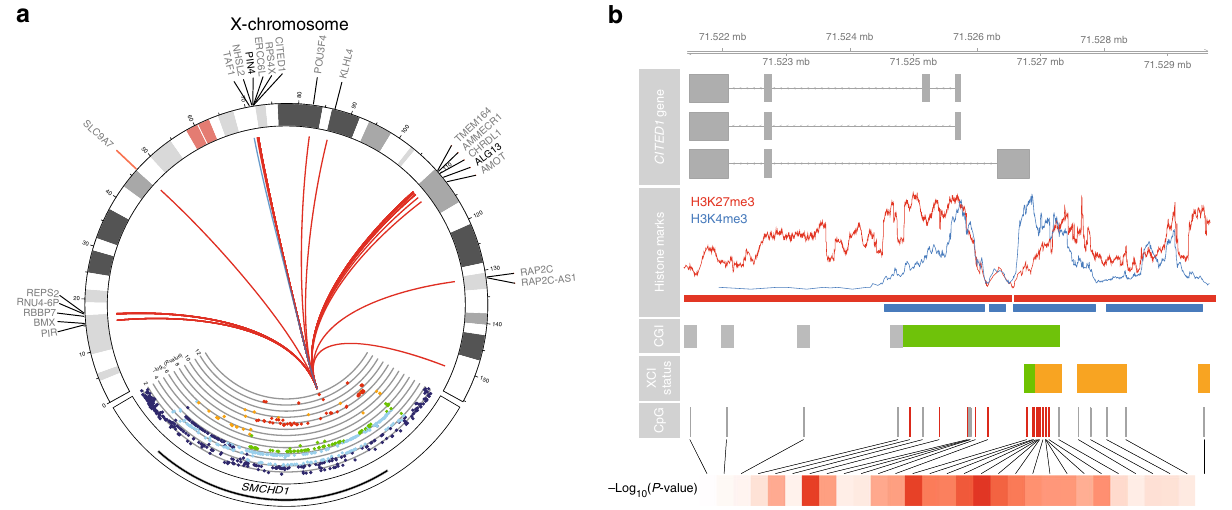
Fig. 2 The SMCHD1 / METTL4 locus associates with DNA methylation at X-chromosomal and autosomal regions. a Plot showing the SMCHD1 / METTL4 locus and the effects it has on the X-chromosome. The colors in the SMCHD1 / METTL4 locus indicate LD (red: R 2 ≥ 0.8; orange: 0.6 ≤ R 2 < 0.8; green: 0.4 ≤ R 2 < 0.6; light blue: 0.2 ≤ R 2 < 0.4; dark blue: R 2 0.6 ≤ 0.2). The y-axis shows the – log 10 ( P -value) of the association with overall X-chromosomal methylation. The line colors in the Circos plot indicate the direction of the effect (red: hypomethylation, blue: hypermethylation). The plot of the SMCHD1 / METTL4 locus mostly shows moderate to high LD and covers most of the SMCHD1 gene. The deletion of rs140837774 is associated with both downregulation of SMCHD1 and upregulation of METTL4 (see main text). Its effects on X-chromosomal methylation are abundant and consistent: the deletion of rs140837774 is associated with hypomethylation at 98.2% of all associated CpGs (56 CpGs, red lines, mean effect size 1% per allele). Hypomethylation of CpGs near two genes known to escape XCI to varying degrees 12 ( PIN4 and ALG13 , shown in bold) is associated with increased expression of these two genes. b Example of CpG island (CGI) in the CITED1 gene ( fi rst row) associated with the SMCHD1 / METTL4 locus. The CpGs associated with the SMCHD1 / METTL4 locus ( fi fth row, indicated by red lines) are overrepresented in regions characterized by both active (blue) and repressive (red) histone marks (second row, red and blue bars, two-fold enrichment, Fisher ’ s P = 1.5 × 10 − 12 ; 6.9-fold enrichment, Fisher ’ s P = 1.5 × 10 − 12 ), are often located in CpG islands (third row, green bar, 11.3-fold enrichment, Fisher ’ s P = 2.5 × 10 − 14 ), and regions known to variably escape X-chromosome inactivation 10 (fourth row, orange bars, 21.4-fold enrichment, Fisher ’ s P = 3.7 × 10 − 18 ). The bottom row indicates the strength of the associations in terms of – log 10 ( P -value) (dark red indicates strong